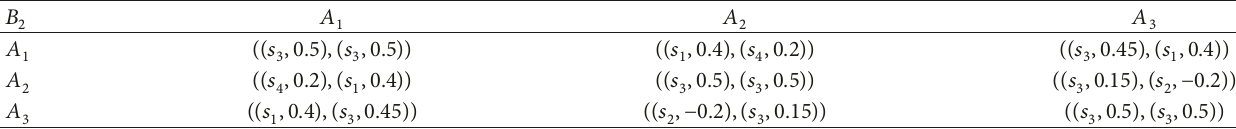
Table 4: I2TLPR of alternatives concerning the criterion 𝐶 2 .